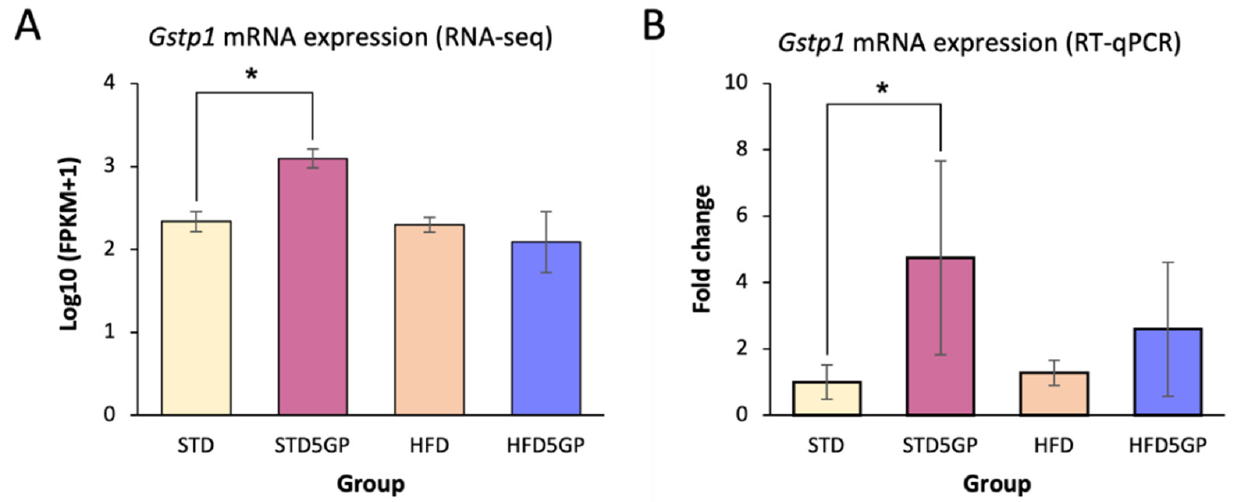
Figure 8. Grape powder supplementation enhances Gstp1 expression in mouse liver. ( A ) Log 10 (FPKM+1) values for Gstp1 expression derived from RNA-Seq data obtained with the liver of mice from the STD5GP group compared with liver of mice from the STD group (* p < 0.0001; two-sample two-tailed t -test). Comparison of the HFD and HFD5GP groups revealed no difference (Padj = 0.782). ( B ) RT-qPCR analysis of Gstp1 expression in the liver of mice from the STD5GP group com- pared to liver of mice from the STD group (* p = 0.001; two-sample two-tailed t -test), and from liver of mice from the HFD5GP group compared with liver of mice from the HFD group ( p = 0.068). Data are presented as mean ± SD of three independent experiments.